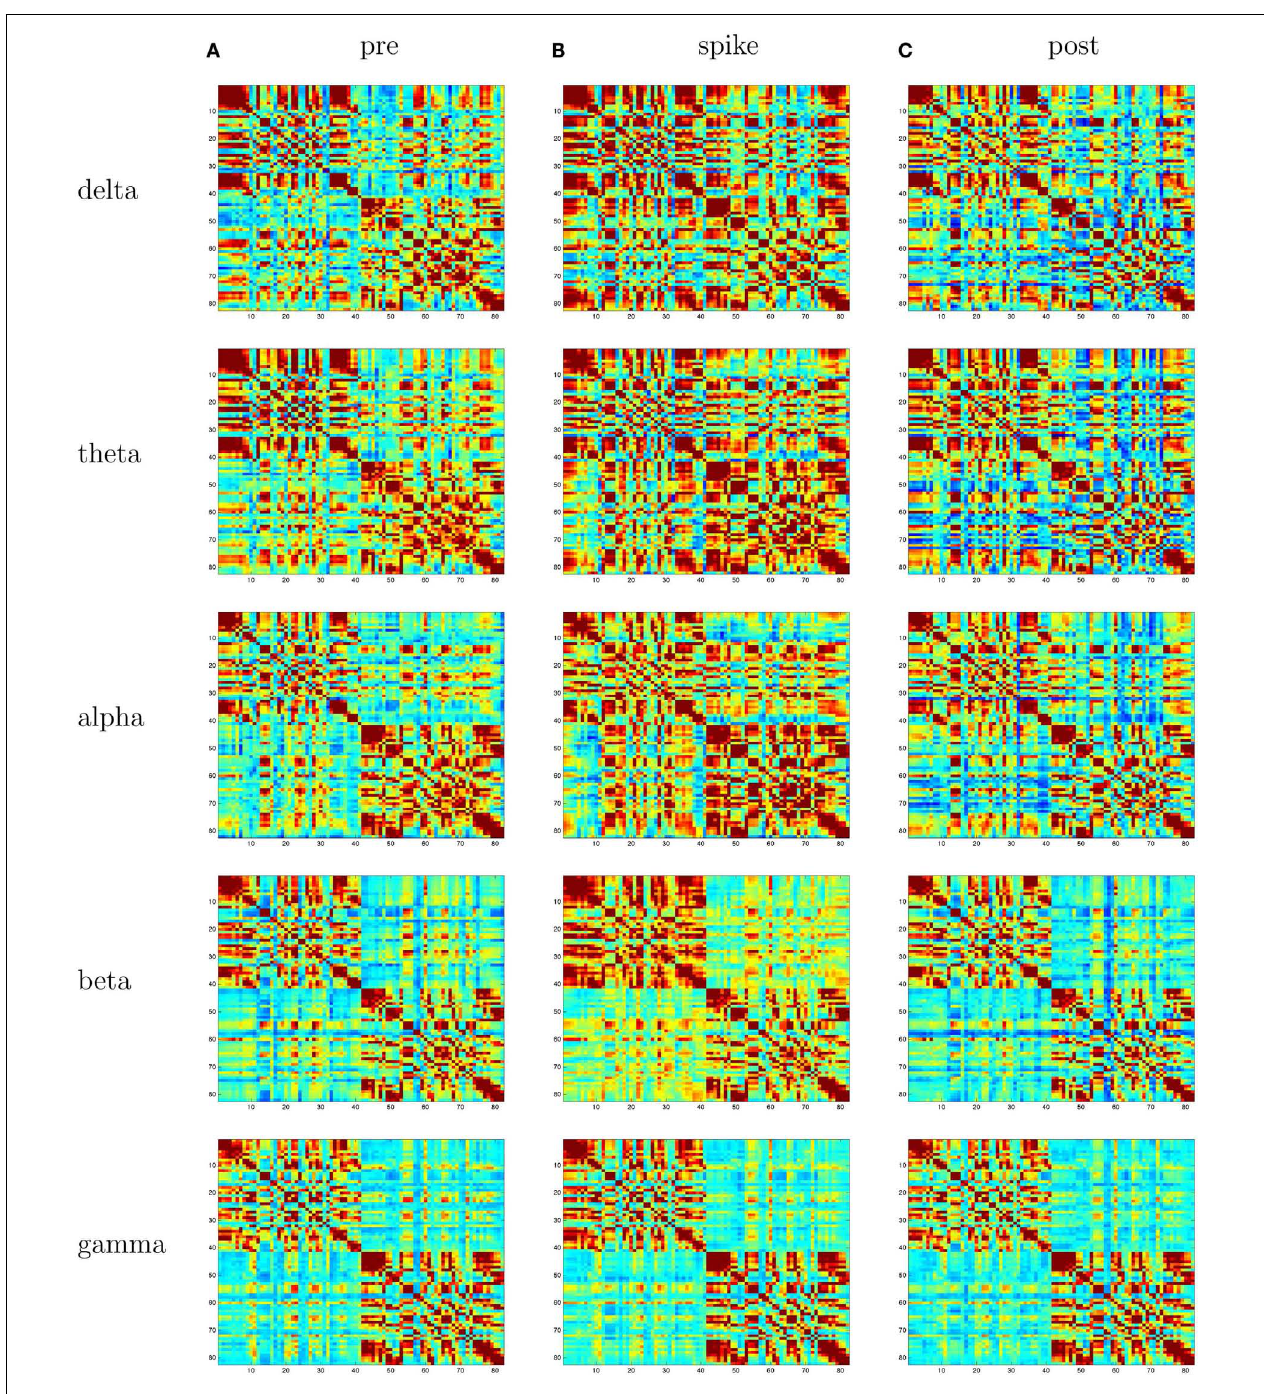
FIGURE 3 | Patient 1’s dEEG cortical source coherence matrices for the delta (0–4Hz), theta (4–8Hz), alpha (8–13Hz), beta (13–30Hz), and gamma (30–70Hz) frequency bands, computed between 82 Brodmann areas (the numbers